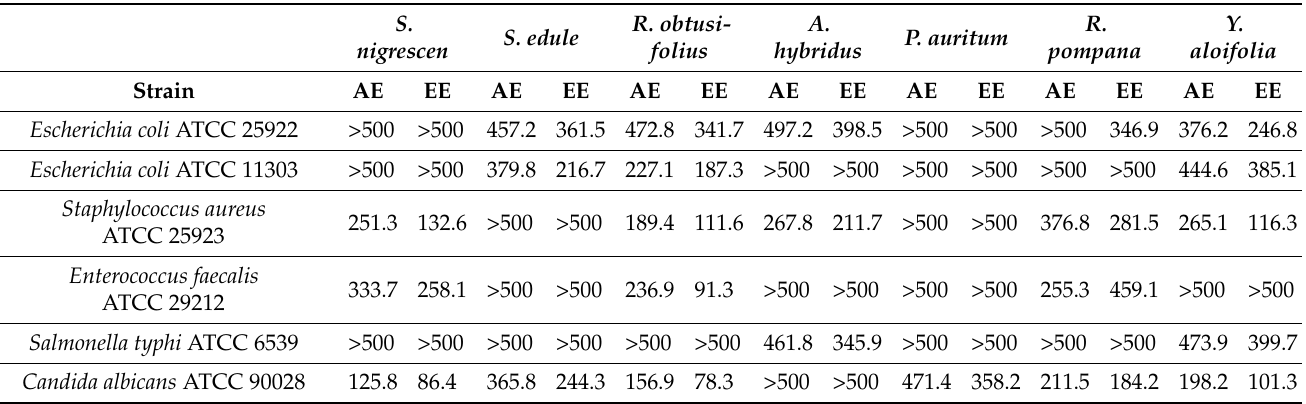
Table 2. Inhibitory activity of aqueous and hydroalcoholic extracts from seven edible plants grown in the northern highlands of Puebla.